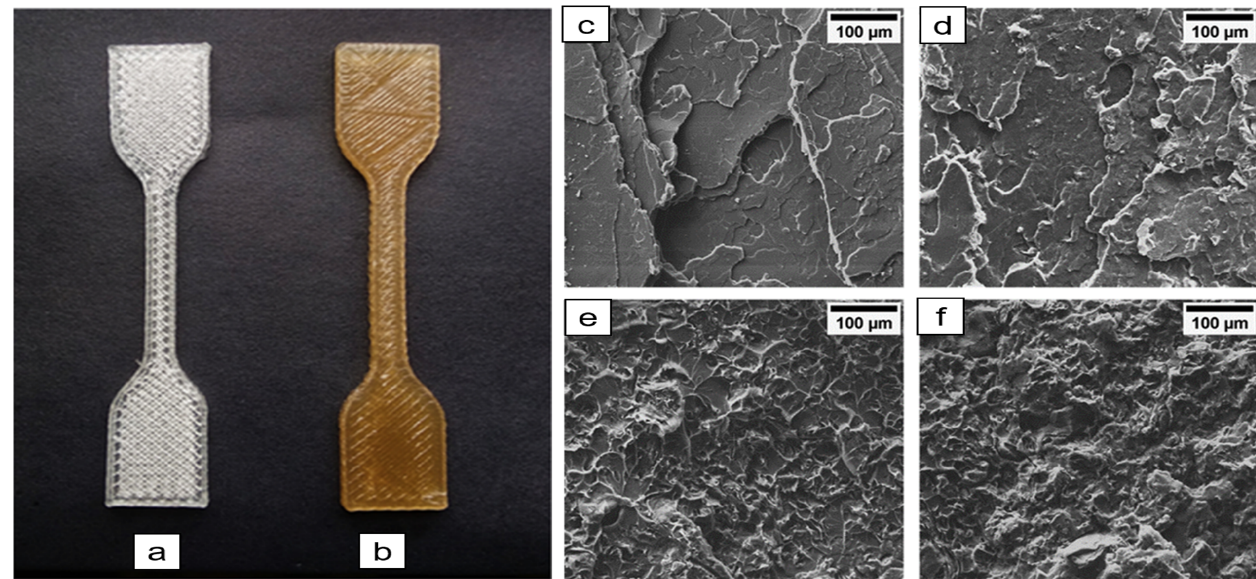
Figure 8. Three-dimensional-printed tensile specimen of PLA ( a ) and PLA/1CNF ( b ) composites, scanning electron microscopy micrographs ( × 600 magnification) of the tensile fractured surface of compression-molded PLA ( c ), PLA/1% CNF ( d ), PLA/3CNF ( e ), and PLA/5CNF ( f ) composites, used with permission from ref. [59].